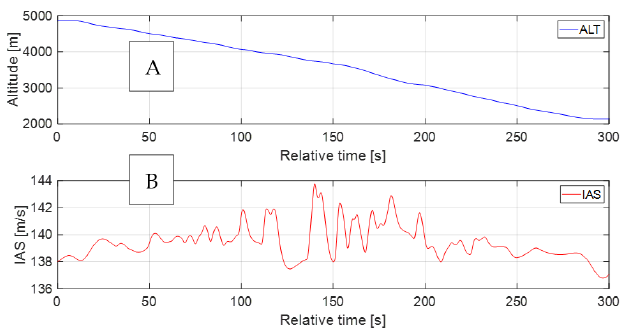
Figure 12. ( A ) Altitude and ( B ) IAS recorded during simulated